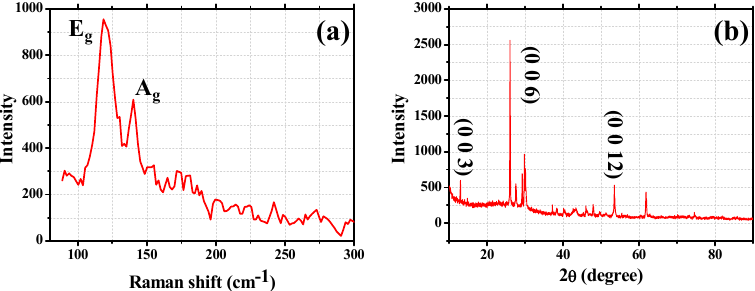
Figure 1. ( a ) The Raman spectrum of the Cr 2 Ge 2 Te 6 nanosheets; ( b ) the X ‐ ray diffraction of the Cr 2 Ge 2 Te 6 nanosheets.